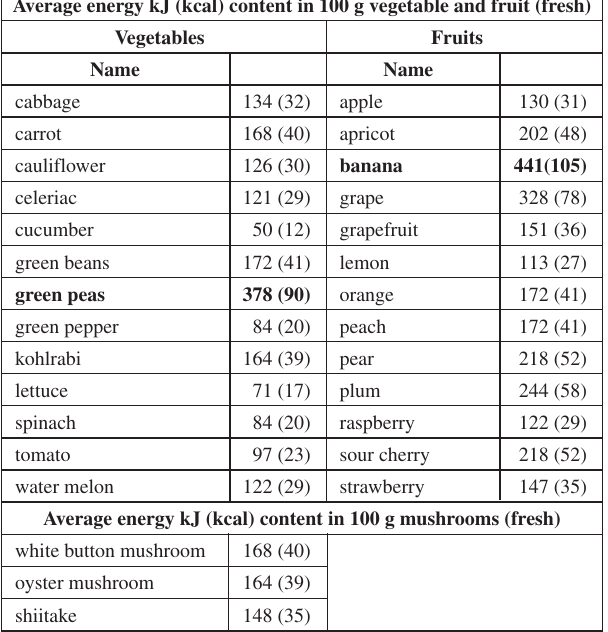
Table 1. Average energy kJ (kcal) content in 100 g vegetables, fruits and mushrooms (fresh) Average energy kJ (kcal) content in 100 g vegetable and fruit (fresh) Vegetables